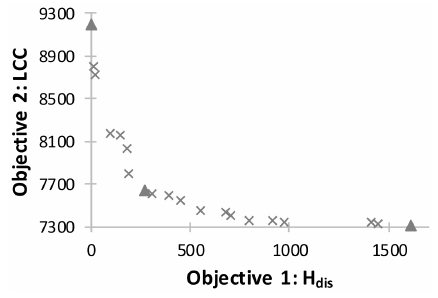
Figure 7. Pareto front for case 5. Table 8. Optimal results for case 5.